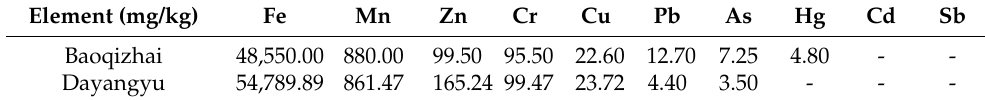
Table 4. Background values of heavy metals in soil samples from Baoqizhai Village and Dayangyu Village (ICP test).